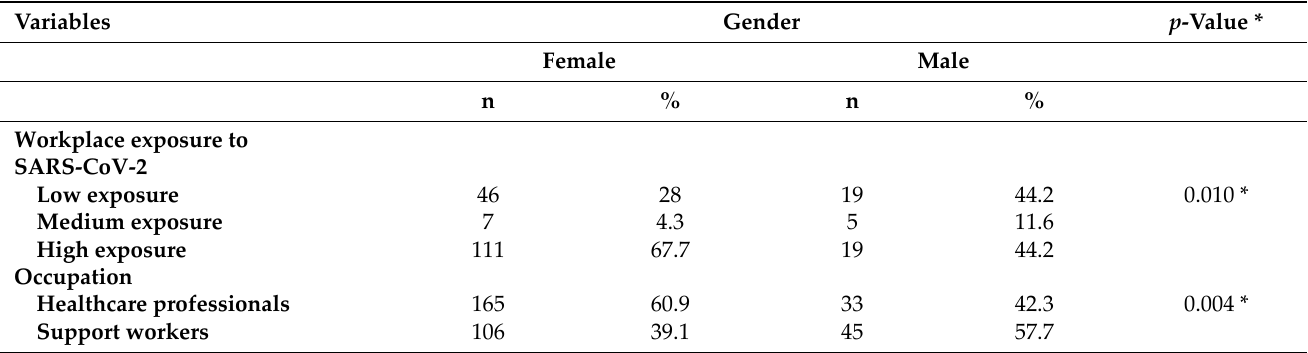
Table 6. Association between gender and types of work activities amongst IFF/Fiocruz